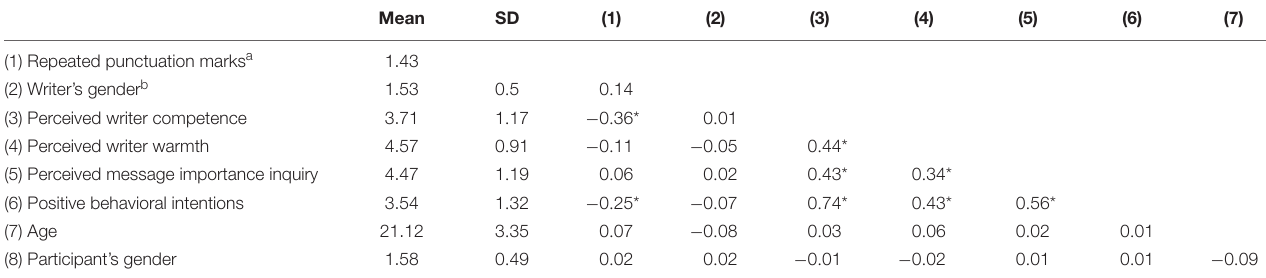
TABLE 1 | Descriptive statistic and correlations for Experiment 1.